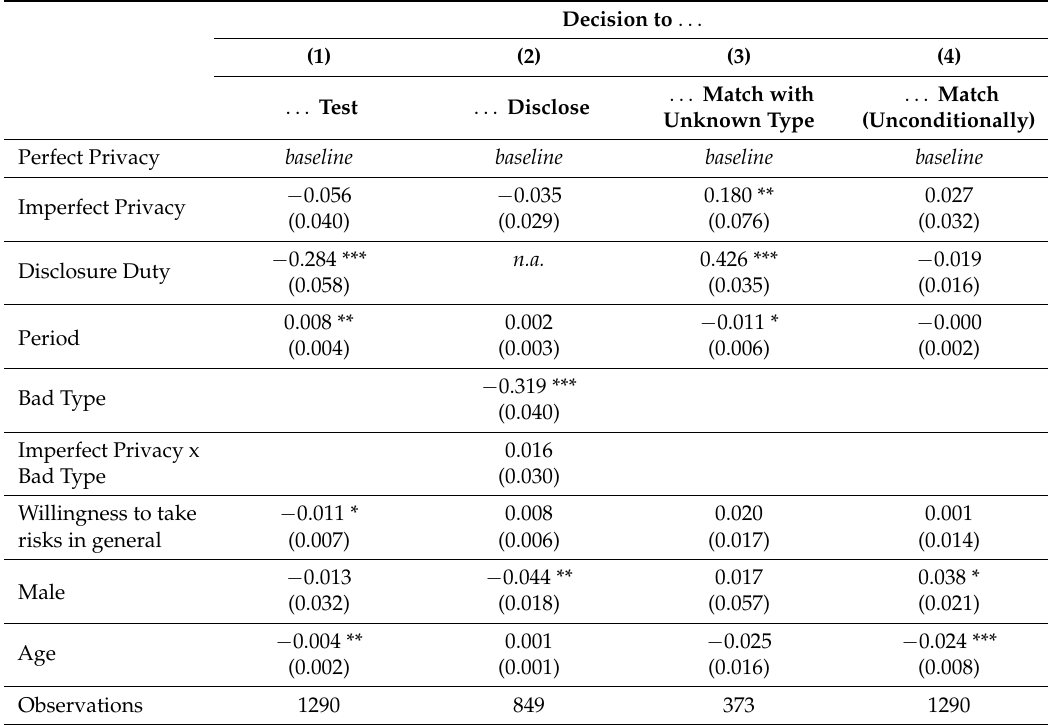
Table 1. Random effects probit regressions (marginal effects), robust standard errors in